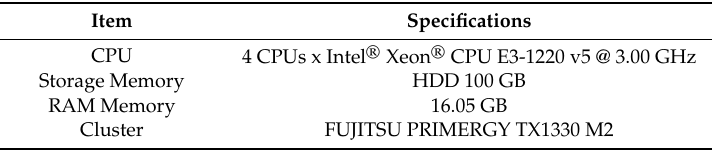
Table 7. Software specifications of the framework.